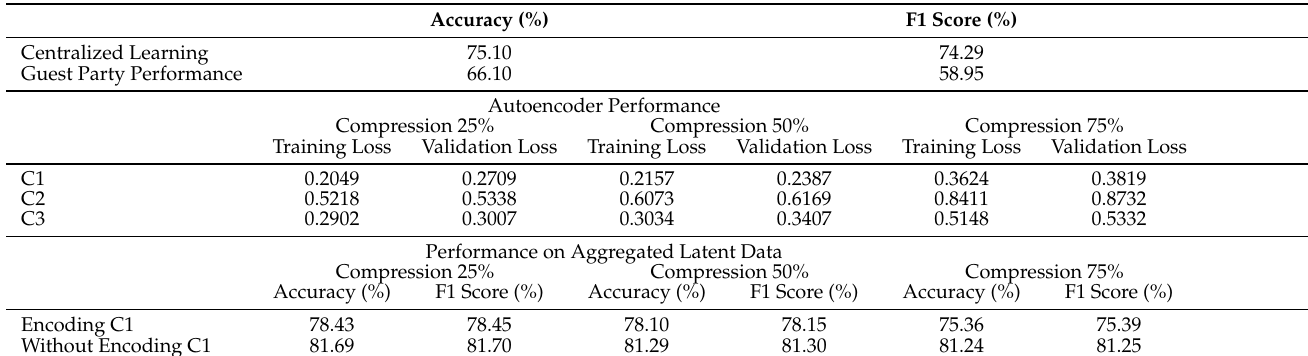
Table 8. Experimental Results on Wine Quality Dataset.